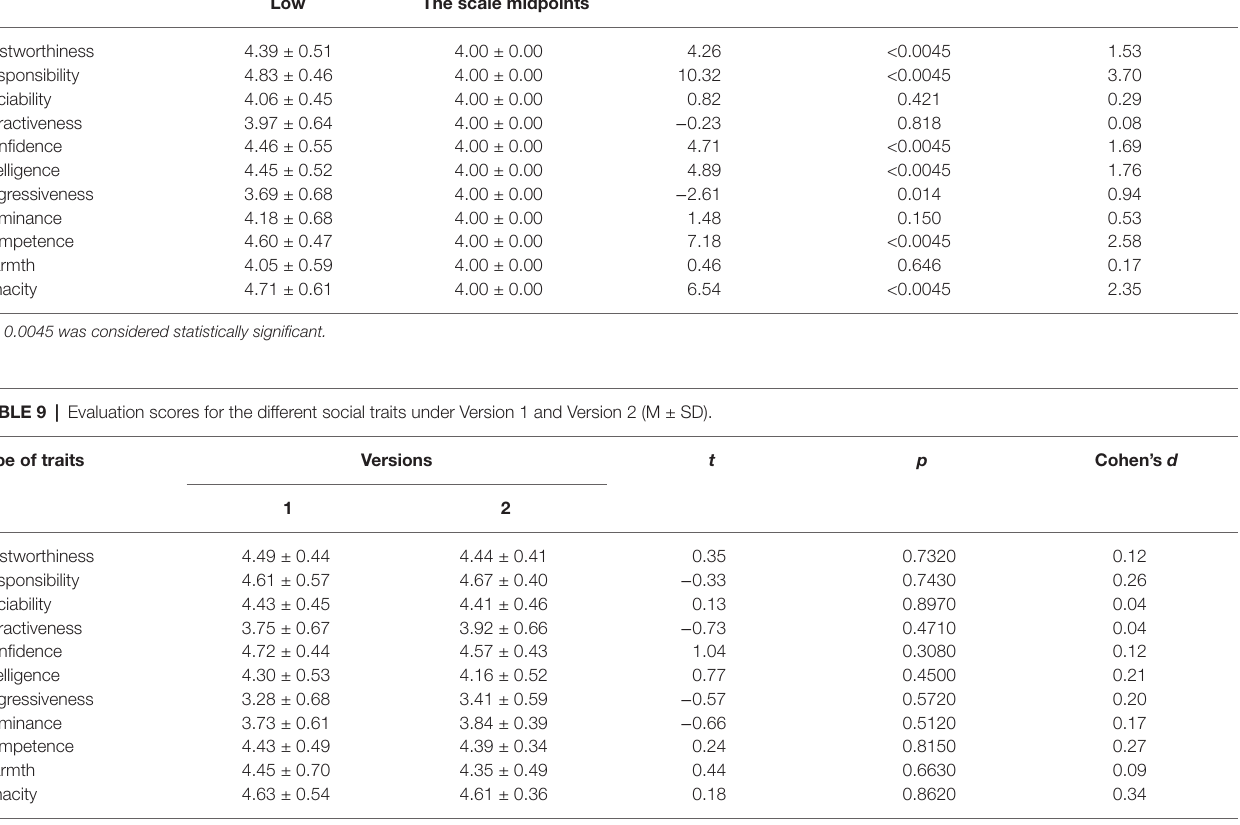
TABLE 8 | Evaluation scores for the traits under low-intensity happy expression and scale midpoints (M ± SD). Type of traits Facial expressions intensity T p Low The scale midpoints Trustworthiness